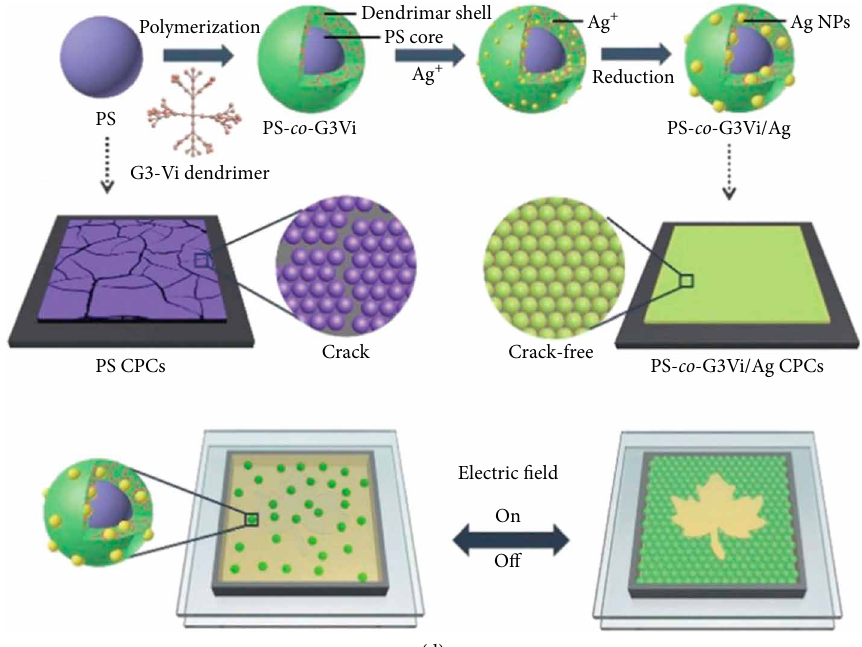
Figure 6: (a) Fabrication of a field-responsive PDMS composite embedded with droplets of EG solution of Fe letters on a flexible PDMS film magnetically induced colour change. Adapted from [167]. (b) Photographs of slides with printed-graphics designed on a computer and latent graphics on P-papers revealed by a magnetic field. Adapted from [169]. (c) Schematic representation of the triphase microfluidic device, the balance of the three interfacial tensions, and the formation of Janus and core –shell CPC supraballs, and their applications as switches and displays. Adapted from [175]. (d) PS-co-G3Vi/Ag microspheres fabricated crack-free CPC and switch of photonic display devices under an electronic field. Adapted from